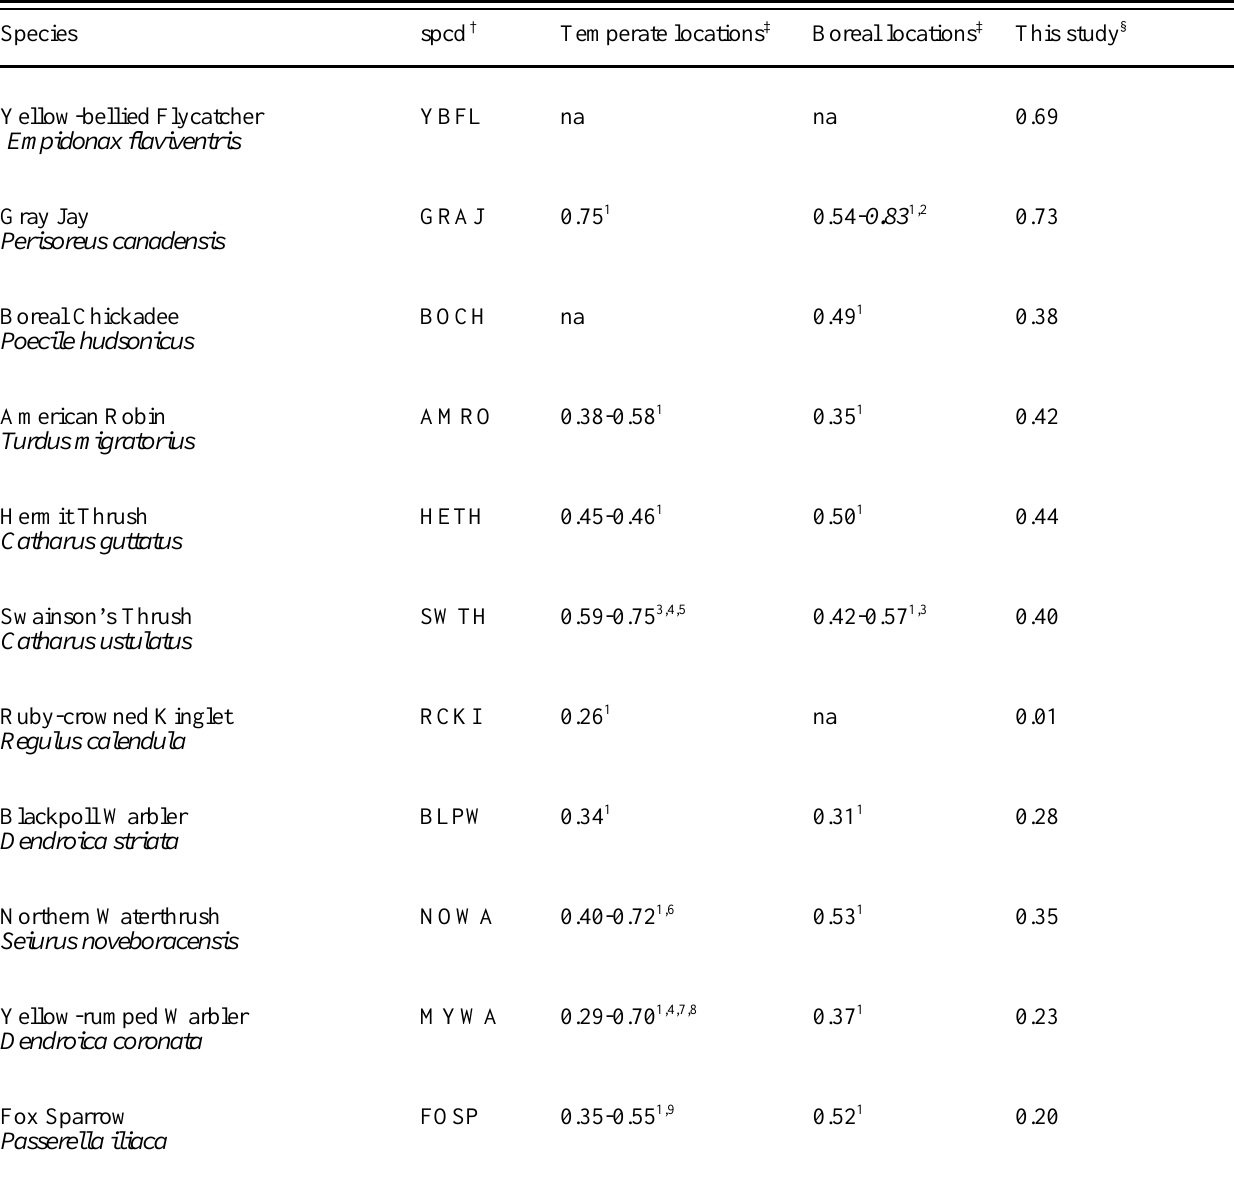
Table 1. List of study species and range of previously published estimates of annual survival. Estimates printed in italics are return rates and would likely be higher if mark-recapture analytical methods had been used to estimate apparent survival. † American Ornithologists Union species code, used to denote species throughout this manuscript. Source of published estimate: 1 DeSante and Kaschube (2006); 2 Strickland and Ouellet (1993); 3 Rosenberg et al. (1999); 4 Nott and DeSante (2002); 5 Gardali et al. (2003); 6 Roberts (1971); 7 Stewart (1988); 8 DeSante et al. (1998); 9 Sandercock and Jaramillo (2002); 10 Karr et al. (1990); 11 Nolan et al. (2002). § Calculated by averaging the annual survival estimates presented in Table 3 across landscape types and (where applicable)